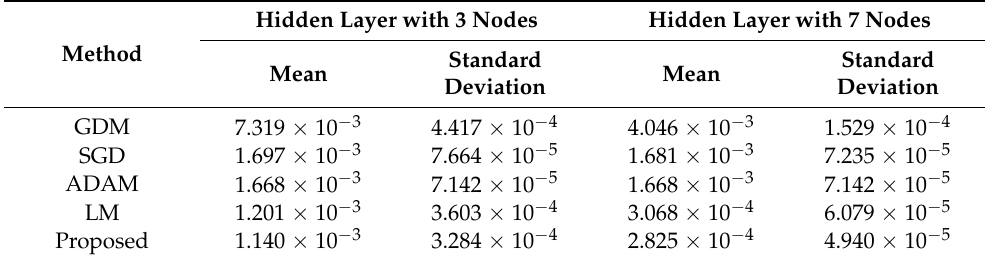
Table 2. Training performance for the pH process after 100,000 iterations—number of iterations and computation time of hidden layer with 7 nodes.